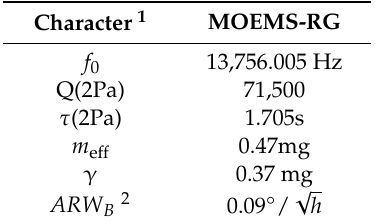
Table 3. Key character parameters of the MOEMS-RG.